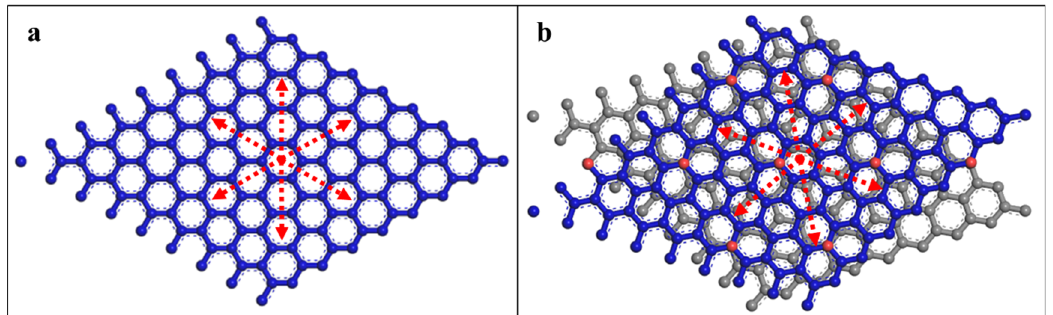
Figure 1. ( a ) Atomic configuration of bilayer graphene (BLG). ( b ) Atomic configuration of twisted bilayer graphene (tBLG) with a twist angle of 21.79°. The atoms marked red are those that overlap with the atoms in the second graphene layer.